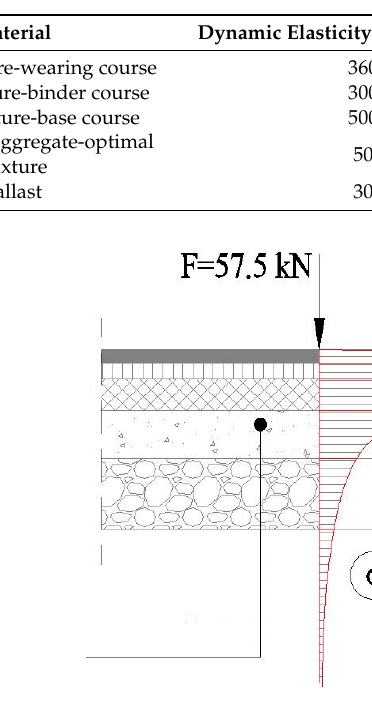
Table 4. Characteristics of the materials composing the flexible road structure.